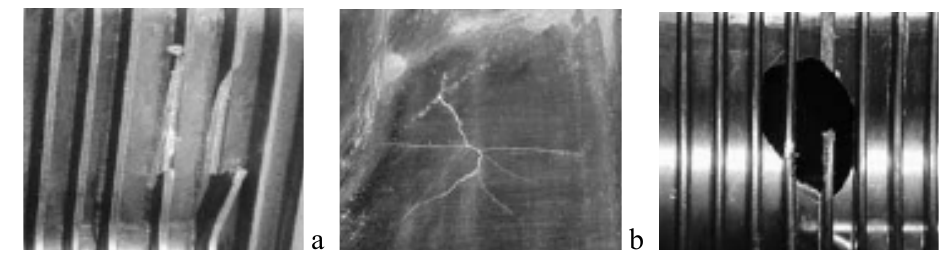
Figure 7. Damage types that can result after an impact. Broken ribs (a), Interior cracks (b), Perforation